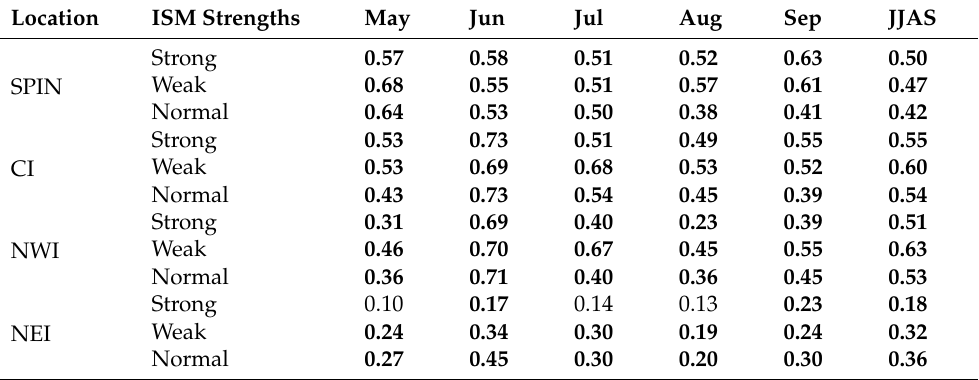
Table 2. Correlation coefficients between daily soil moisture and daily rainfall averaged over SPIN, CI, NWI, and NEI during strong, weak, and normal ISMs. Correlation coefficient in bold font is significantly different from zero at a 95% confidence level using a two-tailed Student- t